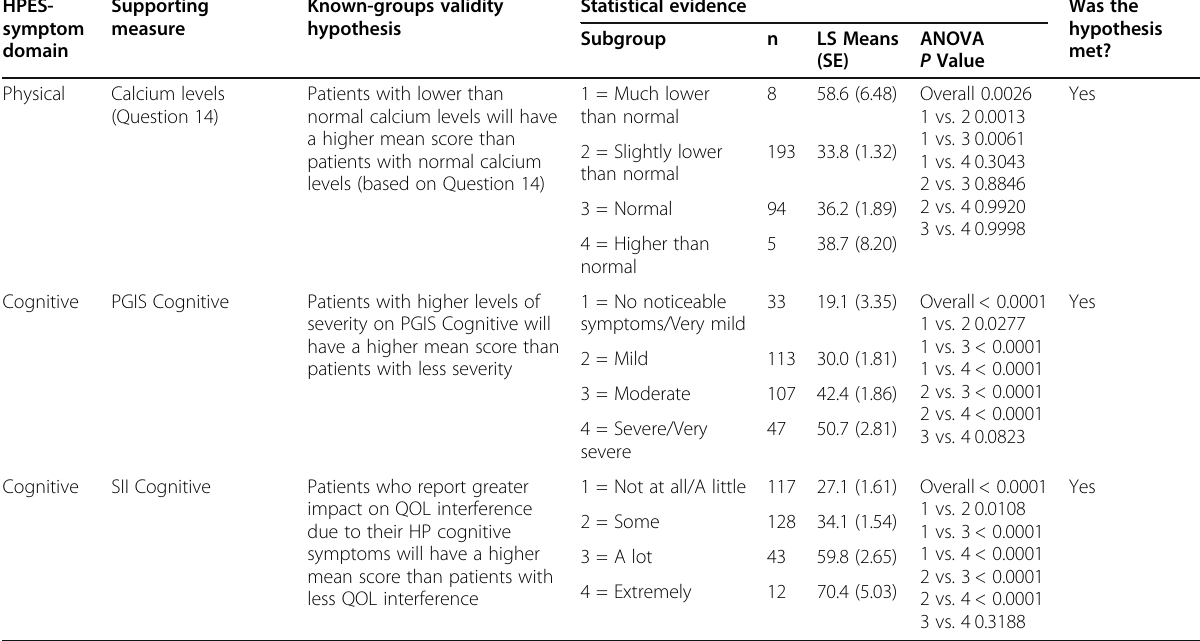
Table 4 Observational study known-groups validity hypotheses for HPES-Symptom (Continued) HPES- symptom